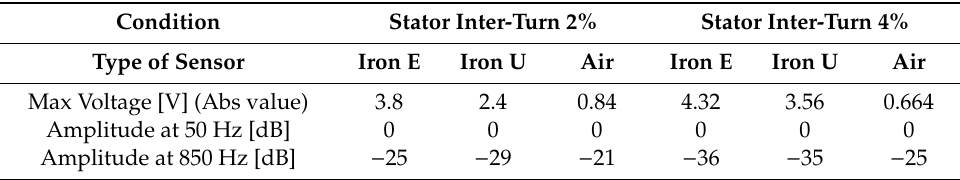
Table 4. Results of stator inter-turn